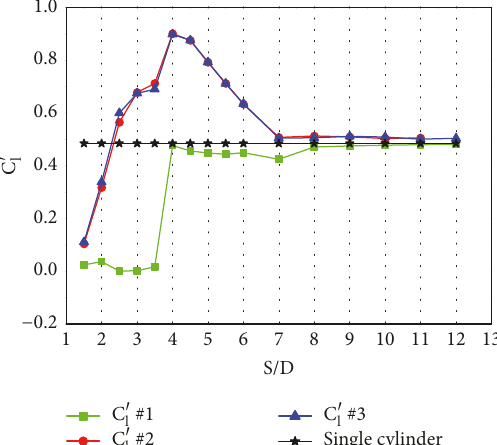
Figure 22: Variations of RMS lift coefficients with different spacing distances for three cylinders.